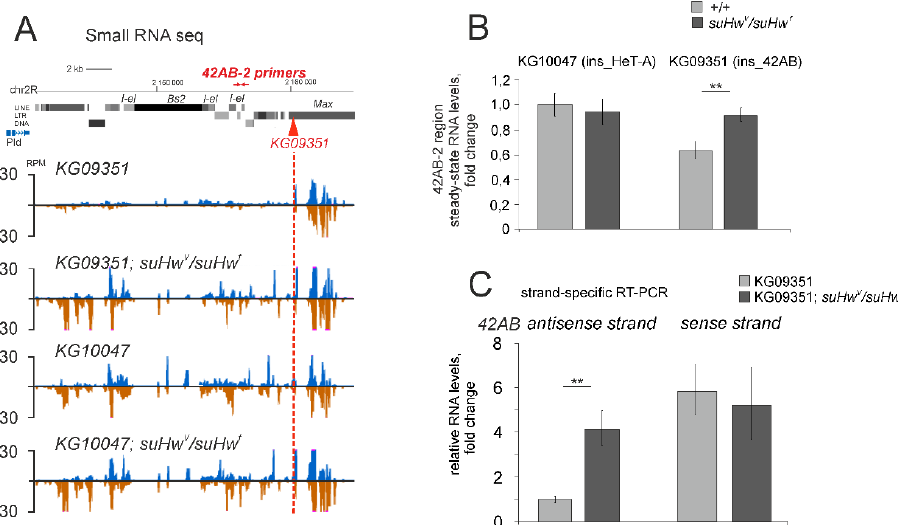
Figure 4. Su(Hw)-binding sites disrupt the integrity of the endogenous piRNA cluster. ( A ) The effect of SUPor-P transgene inserted in the 42AB locus on piRNA expression. Profile of ovarian small RNA density at the 42AB region adjacent to the KG09351 transgene in wild type and su(Hw) V /su(Hw) f mutant flies and in the KG10047 strain without a transgene insertion in this region. The position of the transgene in the minus genomic strand is designated by a red rectangle. Genomic coordinates are indicated according to the dm6 genome assembly. ( B ) RT-qPCR analysis of the expression levels of the 42AB region located 4 kb downstream of the KG09351 transgene. The positions of the primers used for RT-PCR are schematically indicated in ( A ). ( C ) Strand-specific RT-PCR using the primers indicated in ( A ) showed a decreased level of RNA from the negative genomic strand downstream of the transgene insertion. Asterisks indicate statistically significant differences in the expression levels between wild type and su(Hw) V /su(Hw) f mutants (* p < 0.05 to 0.01, ** p < 0.01 to 0.001, *** p < 0.001, unpaired t -test).